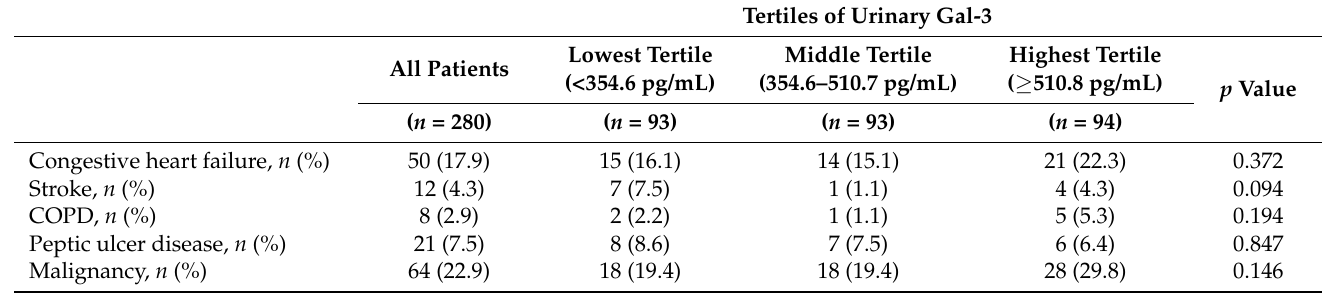
Tertiles of Urinary Gal-3